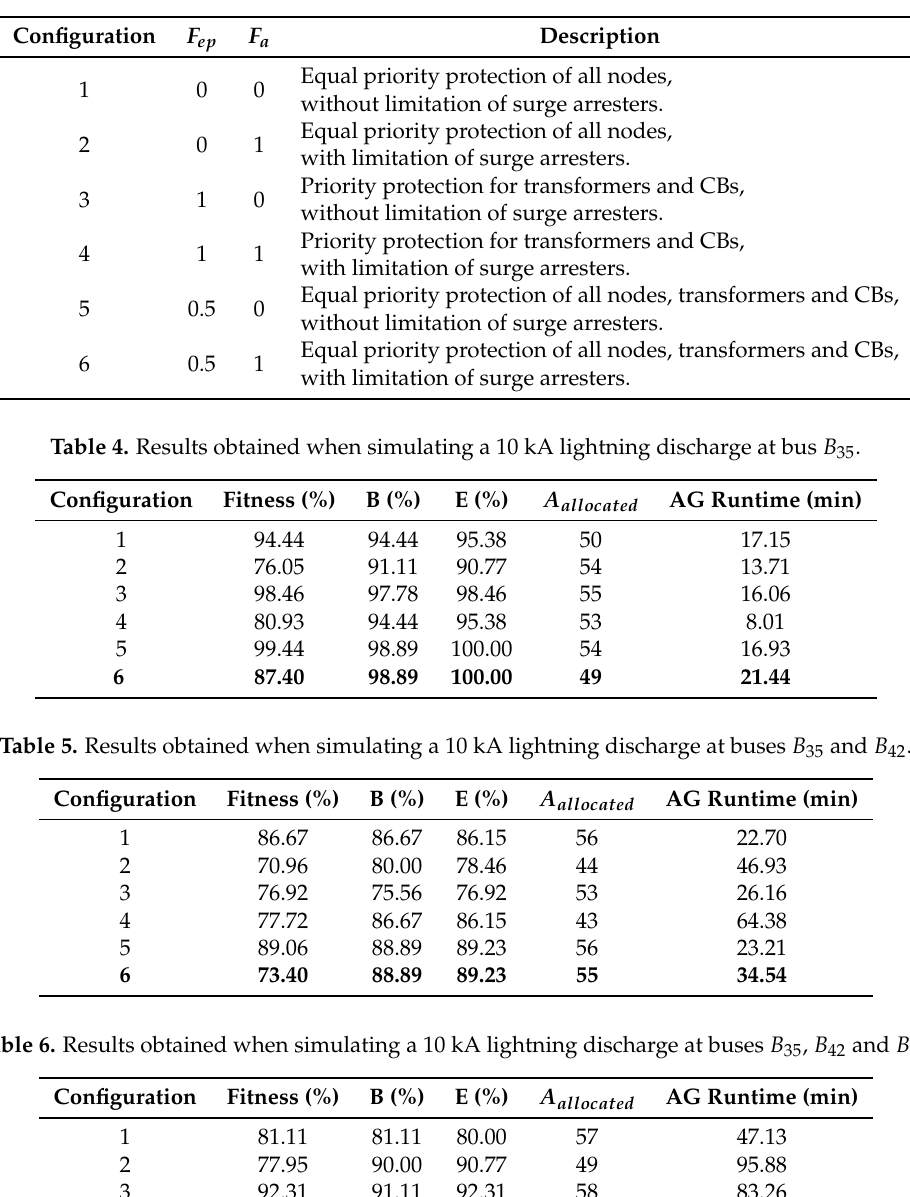
Table 3. Fitness configuration.